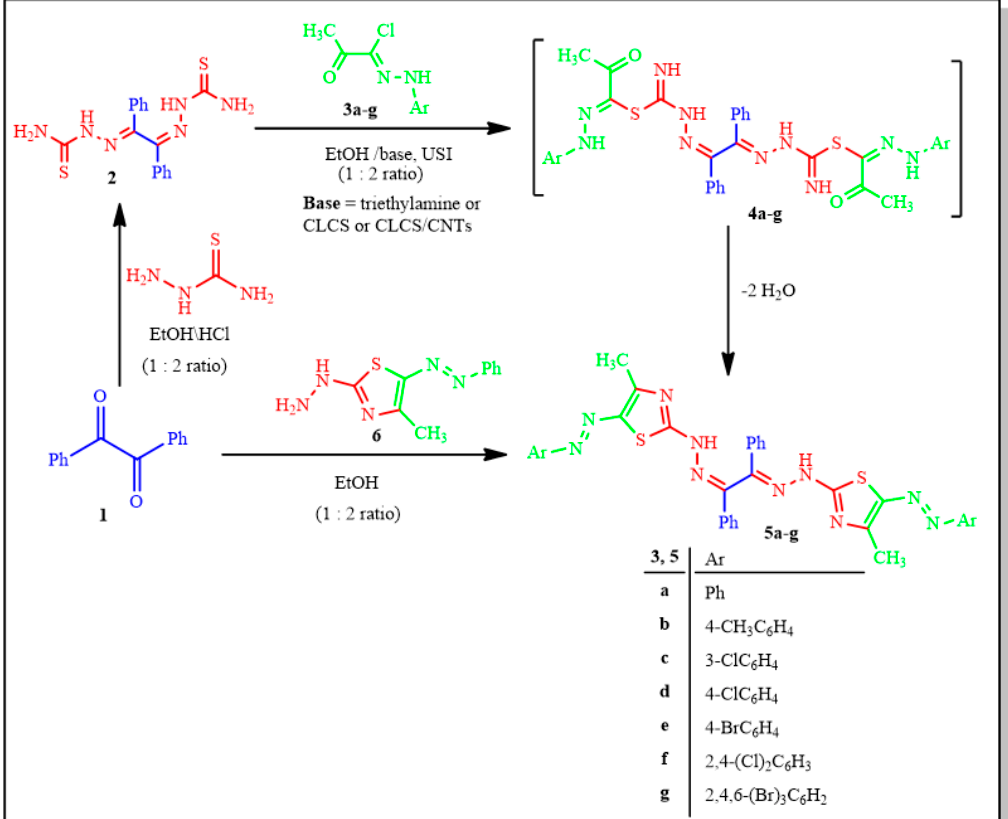
Table 2. Comparison of synthesis of bis-thiazoles 5a–g under ultrasound irradiation using a different basic catalyst on the time of reaction and the yield % of the products. Compound